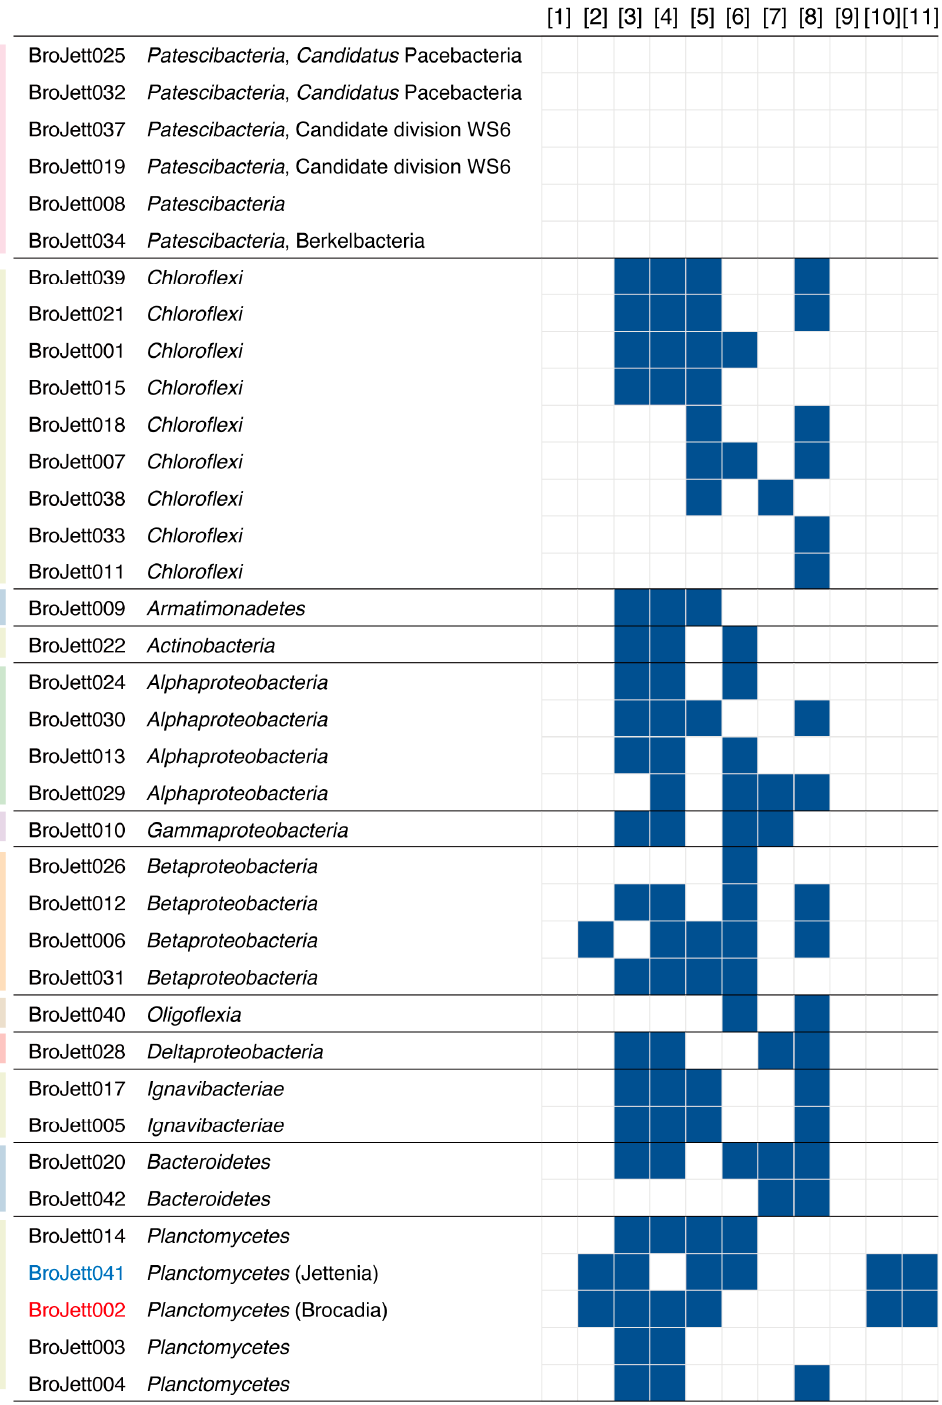
Figure 3. Presence/absence of nitrogen marker genes annotated using KEGG (Kyoto Encyclopedia of Genes and Genomes) and Blastp. The numbers in square brackets on the horizontal axis represent the following genes: [1] ammonia oxidation (amoA and amoBC, pmmo), [2] hydroxylamine oxidation (hao), [3] nitrite oxidation (nxrAB), [4] dissimilatory nitrate reduction (narGH and/or napAB), [5] DNRA (nirBD and/or nrfAH), [6] nitrite reduction (nirK or nirS), [7] nitric oxide reduction (norBC), [8] nitrous oxide reduction (nosZ), [9] nitrogen fixation (nifKDH), [10] hydrazine dehydrogenase (hdh), and hydrazine synthase (hzs). The colored lines next to the bins correspond to the phyla shown in Figure 2. The text colors of BroJett041 and BroJett002 correspond to Figure 4 and represent Candidatus Jettenia caeni and Candidatus Brocadia sinica, respectively.